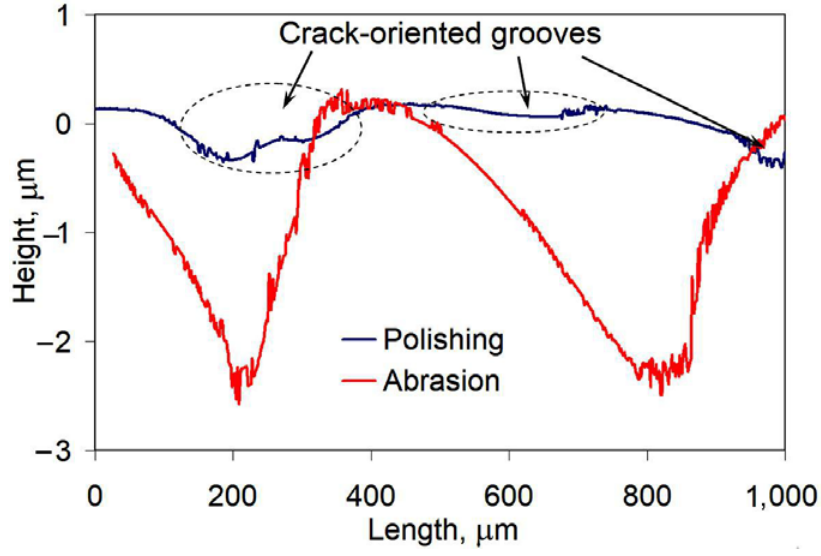
Figure 10. Surface profile of the coating after polishing and abrasive wear testing.